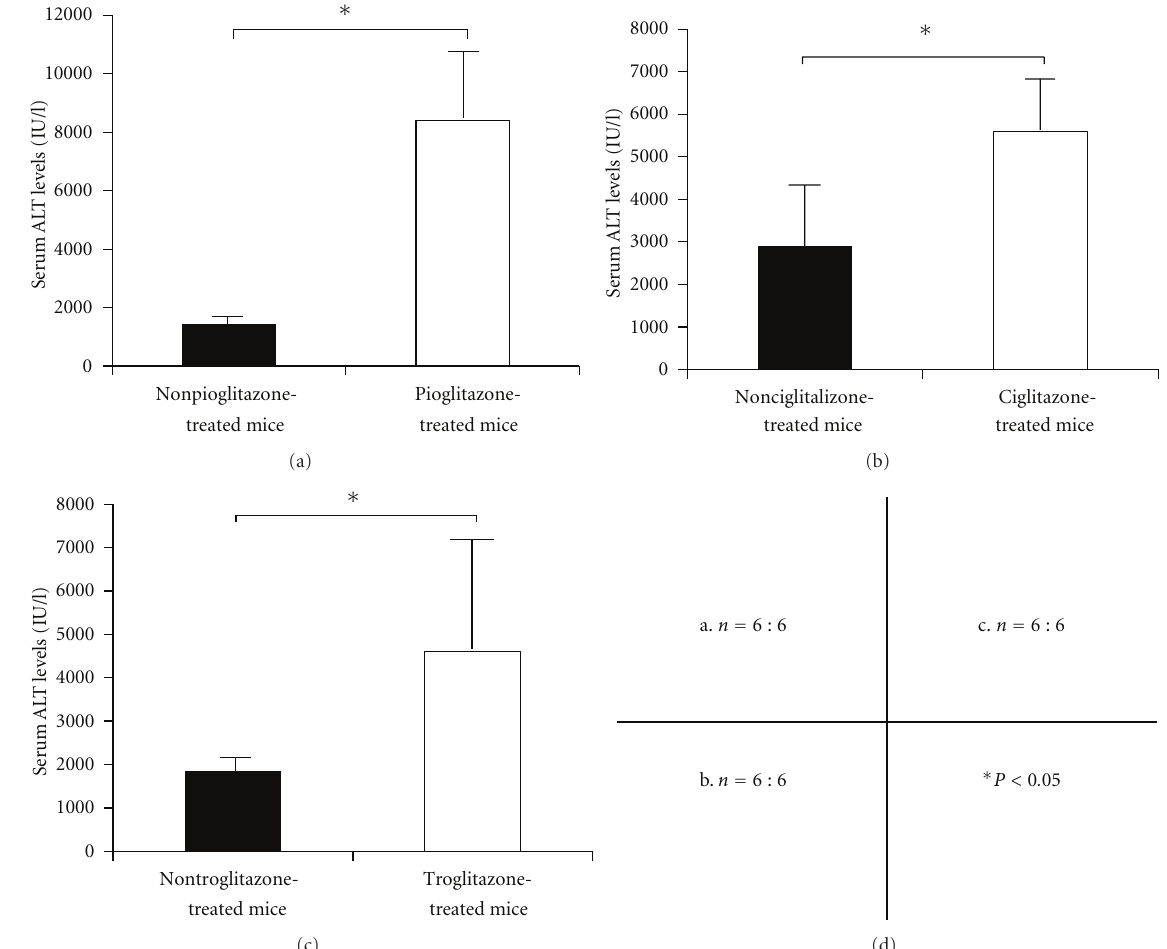
Figure 1: At 20 h after Con A injection, the serum ALT levels in the mice treated with one of the three types of PPAR γ ligands (pioglitazone (a), troglitazone (b), ciglitazone (c)) were significantly higher as compared with those in the non-PPAR γ -treated mice ( ∗ P < 0 . 05).